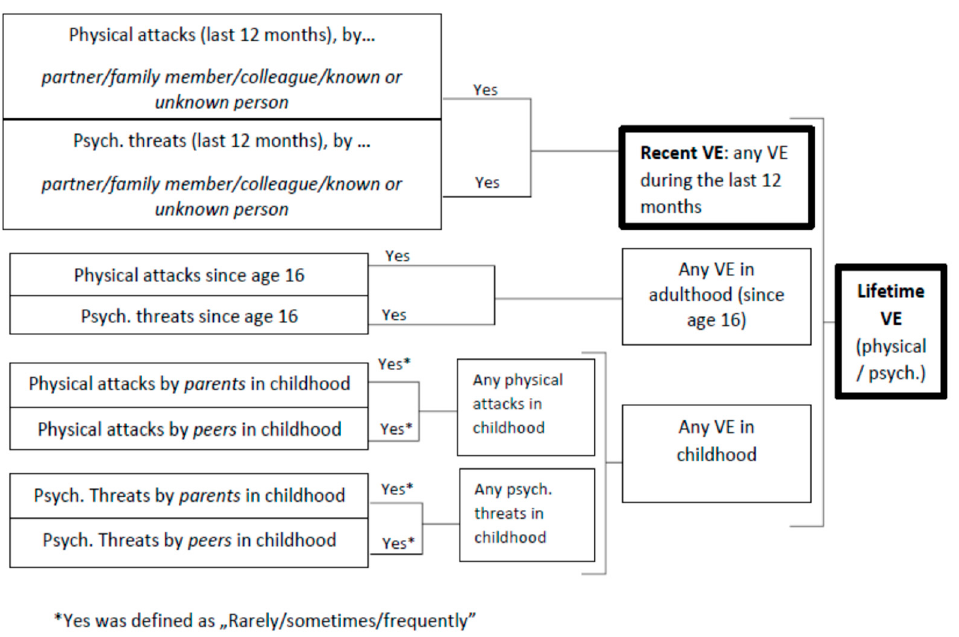
Figure 1. DEGS1 variables computed to measure recent and lifetime physical and psychological violence experience.